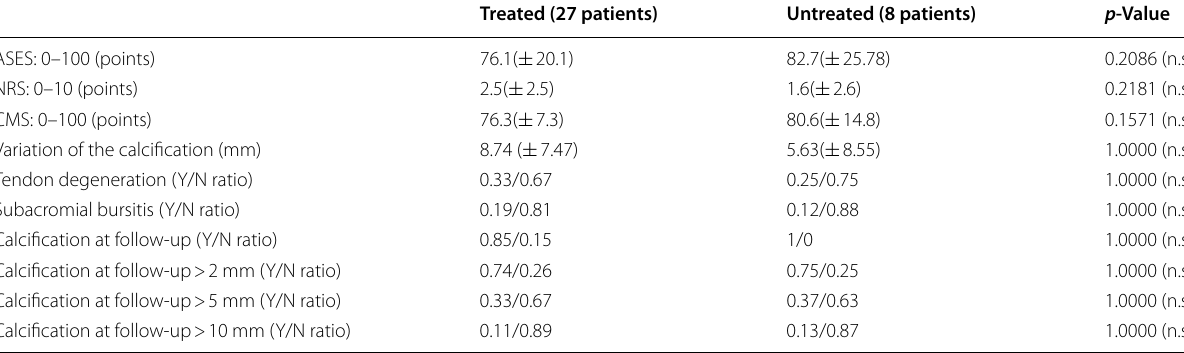
Data expressed as mean ( SD) or frequency/ratio ± ASES American Shoulder and Elbow Surgeons Score, CMS Constant–Murley score, mm millimeters, NRS numeric rating scale, n.s. not significant, SD standard deviation, Y yes, N